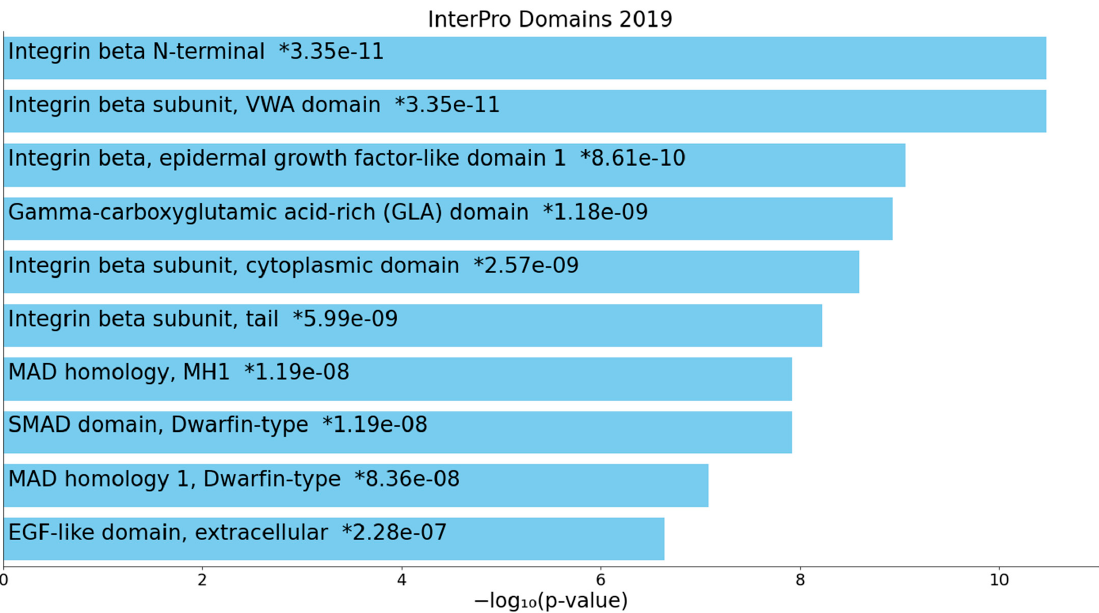
Figure 6. Heatmap of enriched InterPro domains showing the top 10 functions that were overexpressed in the second protein subnetwork of patients who died due to ischemic stroke (accumulative hypergeometric p -values). VWA: von Willebrand factor type A; MAD: Mothers against Dpp (decapentaplegic); MH1: MAD 1 homology (N terminus); SMAD: Superfamily of Mothers against Dpp; EGF: Epithelial growth factor. “Colored bars correspond to terms with significant p -values (<0.05); the * indicate that the term has a significant adjusted p -value (<0.05)” (Appyters, Appyter (maayanlab.cloud) as accessed on 6 November